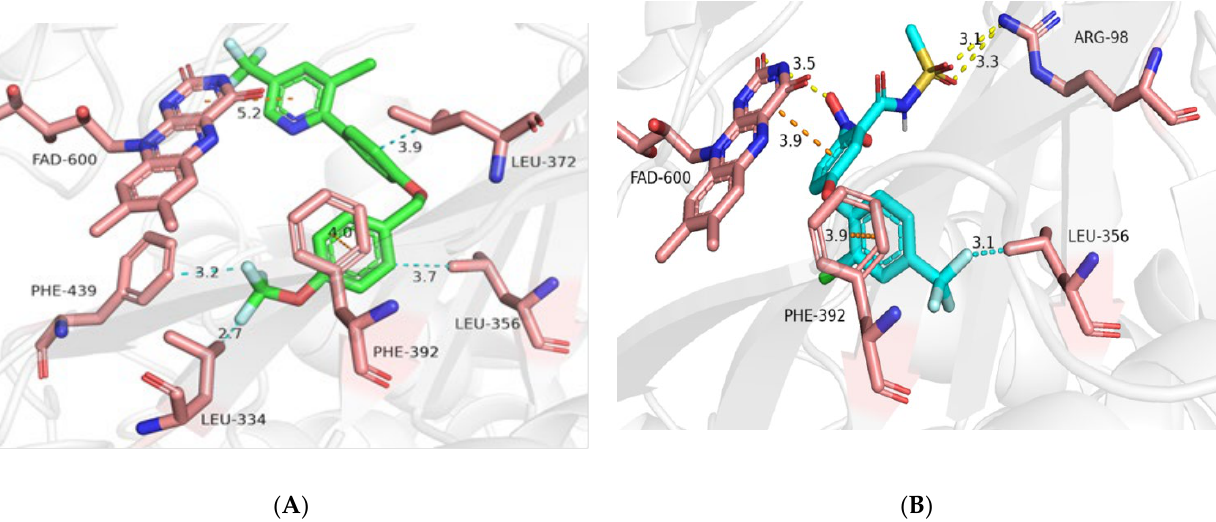
Figure 5. ( A ) Docking model for compound 7a with the protoporphyrinogen oxidase active site; ( B ) docking model for fomesafen with the protoporphyrinogen oxidase active site. The carbon atoms are shown in springgreen ( A ) and cyan ( B ); the fluorine atoms are shown in aquamarine ( A , B ); the oxygen atoms are shown in red ( A , B ); the chlorine atoms are shown in green ( A , B ); the nitrogen atoms are shown in blue ( A , B ); the sulfur atom is shown in yellow (B).